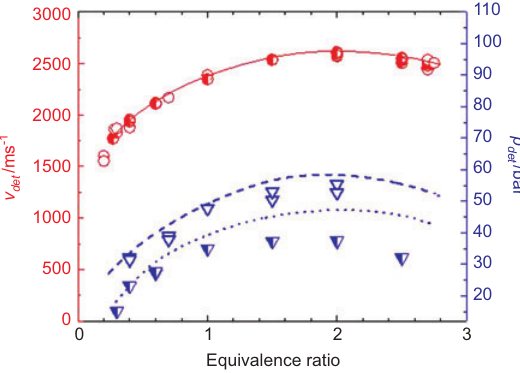
Figure 12 Dependence of detonation velocity and pressure on the composition of ethane/O mixtures. 2